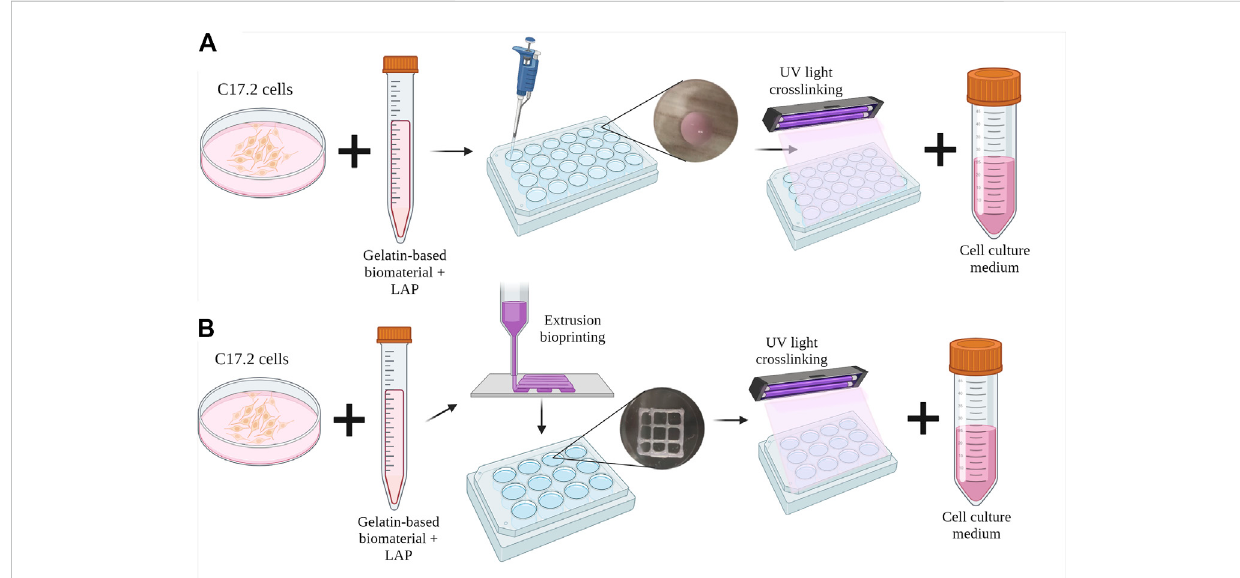
FIGURE 1 Schematic diagram of the inclusion of C17.2 cells in the hydrogel (A) in the drop-shaped samples and (B) in extrusion bioprinted samples. Created with Biorender.com.